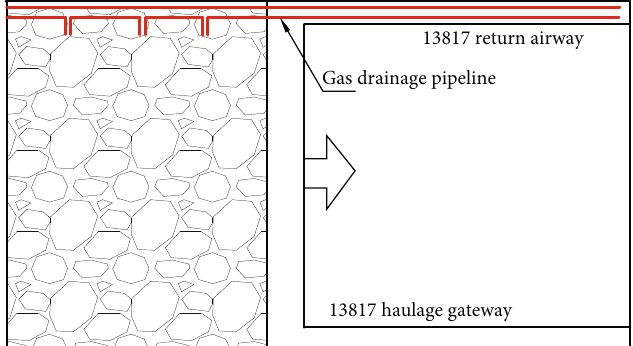
Figure 24: Schematic diagram of gas in goaf with buried pipe at upper corner.